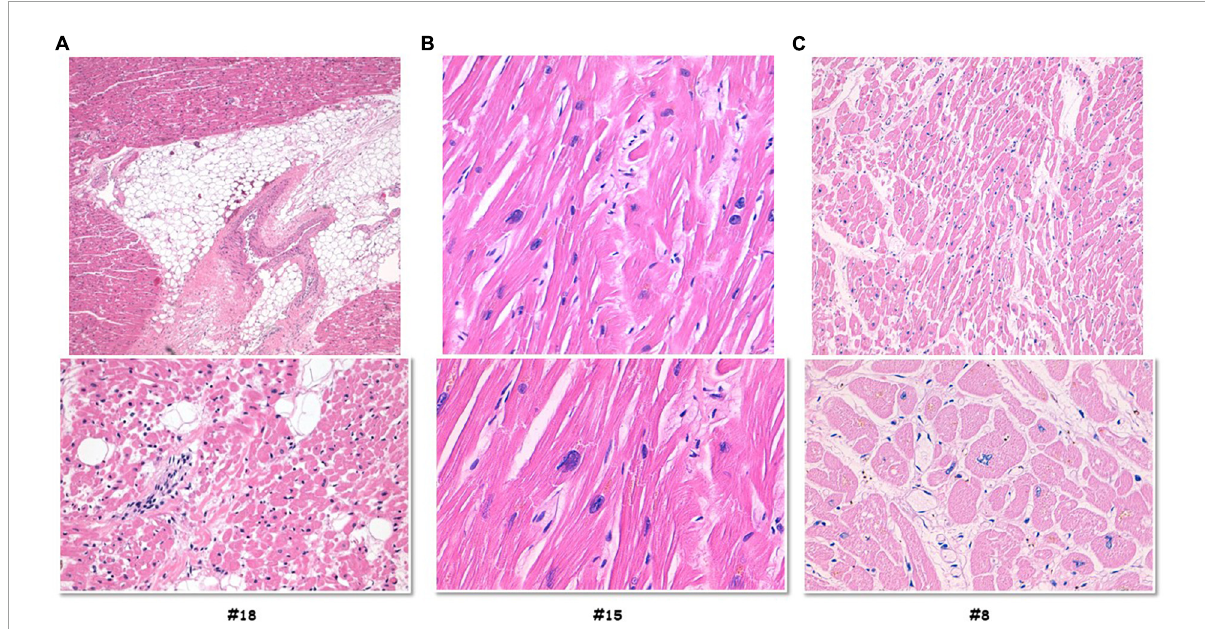
FIGURE2 Histology investigation of three selected sudden cardiac death cases. Hematoxylin and eosin staining performed on myocardial samples of the ventricles. Case #18, (A) histology showed myocytes loss and disorganization with replacement of fibro-fatty tissue; myocardial inflammatory infiltrates were present, but granulomas or giant cells were absent. Case #15, (B) the images showed myocytes disarray with storiform pattern, and occasionally myocytes exhibiting nuclear enlargement and hyperchromasia. Masson trichrome stain displayed interstitial and replacement-type fibrosis. Case #8, (C) analysis of conduction system and ventricular tissue did not reveal microscopic anomalies or inflammatory changes.